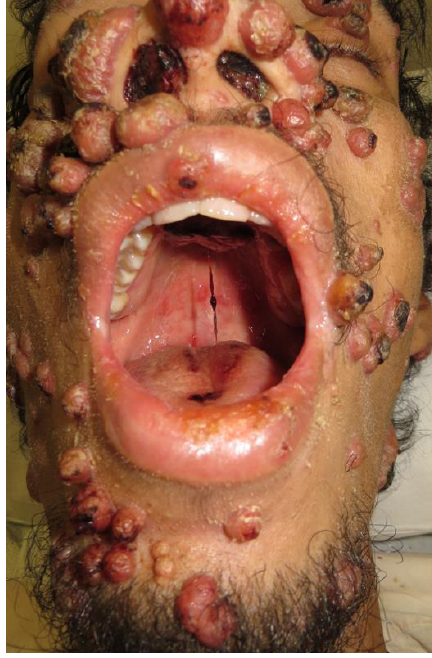
Figure 2. Disseminated sporotrichosis in a 25-year-old man (Case 4). Multiple papular and nodular- ulcerative facial lesions, with aerodigestive tract impairment. Involvement of the nasal mucosa and palate is shown.